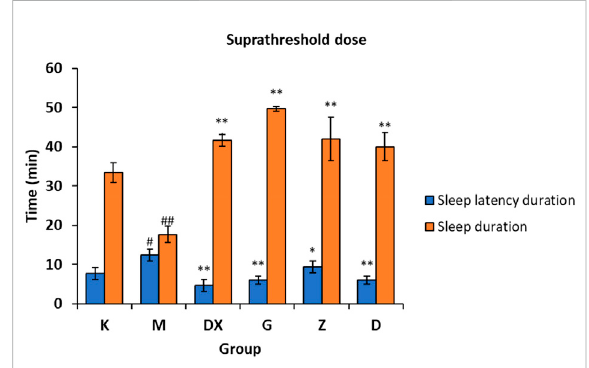
FIGURE 4 Effects of R-S on the suprathreshold dose of